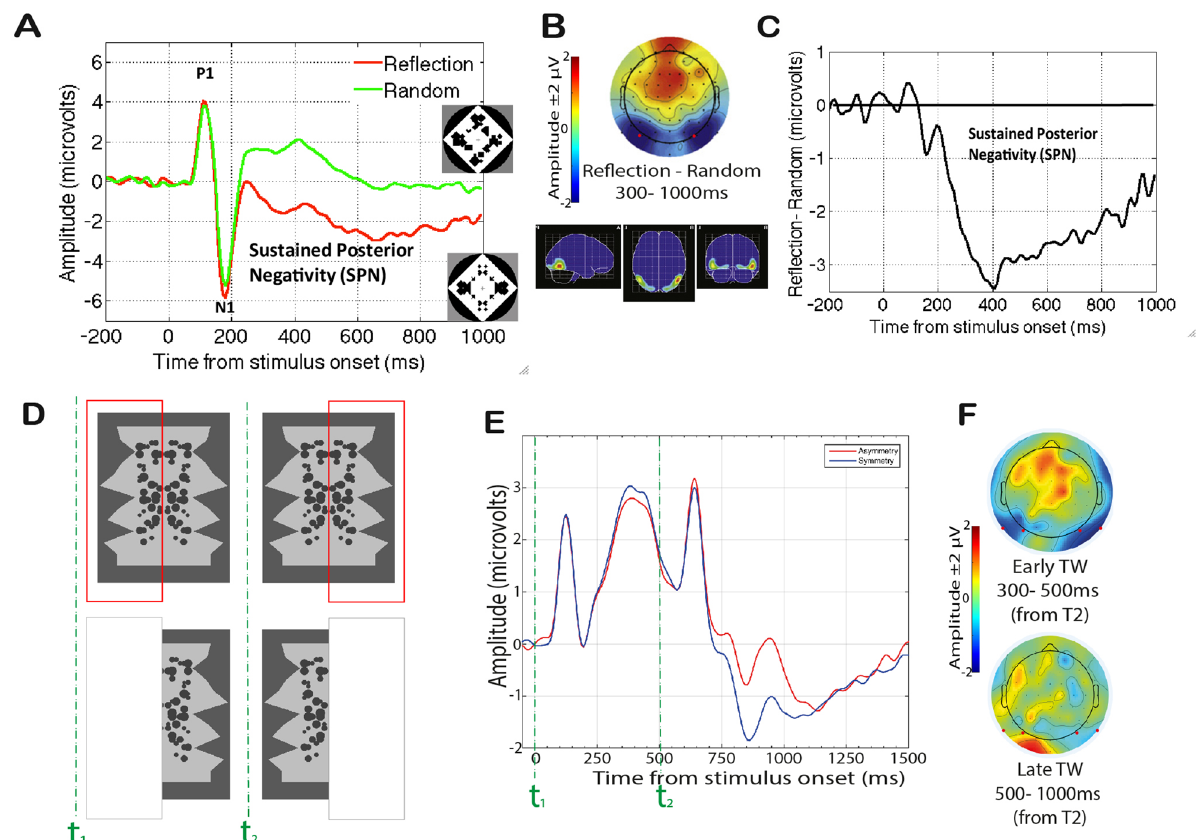
Figure 1. Sustained Posterior Negativities from previous research. ( A – C ) Results from Makin et al. 42 , Experiment 1 ( A ) Grand average ERP averaged across electrodes PO7 PO8 in reflection (symmetry) and random (asymmetry) conditions. Example stimuli are shown in insets. ( B ) Topographic difference map from 300 to 1000 ms post stimulus onset (SPN is coded as blue at posterior electrodes) and estimated cortical sources of the grand average SPN. ( C ) Grand average SPN shown as a difference wave (symmetry–random). (D-F) Stimuli and Results from Rampone et al. 51 , Experiment 1 ( D ) Examples of stimuli (symmetric shapes). The example on the top reports the full shape; the red bar mimics the actual occluder bar presented in the experiment. On the bottom, example of the same shape with the occluder. ( E ) Grand average ERPs averaged across electrodes P9 PO7 P10 PO8. From 0 ms (t1) to 500 ms the first half of a polygon shape was visible. At 500 ms (t2) the occluder moved and revealed the hidden half, whilst covering the previously visible part. After ~ 300 ms, a symmetry–asymmetry ERP was observed. ( F ) Topographic difference maps (Symmetry– Asymmetry) from the time-window 300–500 ms and 500–1000 ms from t2. Red dots indicate electrodes